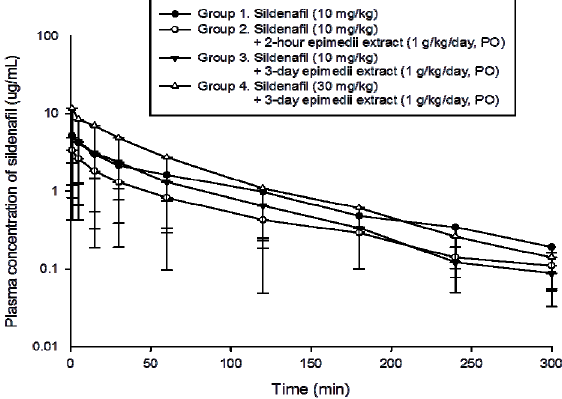
Figure 2. Plasma concentration-time profile of intravenous sildenafil in the blood of group 1: sildenafil alone (10 mg/kg); group 2: Low dose Epimedium sagittatum (Sieb. et Zucc.) Maxim extract (1 g/kg) 2 h pretreated + sildenafil (10 mg/kg), group 3: low dose Epimedium sagittatum (Sieb. et Zucc.) Maxim extract (1 g/kg/day) for 3 consecutive days and on day 4 + low dose sildenafil (10 mg/kg); group 4: low dose Epimedium sagittatum (Sieb. et Zucc.) Maxim extract (1 g/kg/day) for 3 consecutive days and on day 4 + high dose sildenafil (30 mg/kg). Data are presented as expressed as mean ± standard error of the mean (S.E.), n = 6 for each